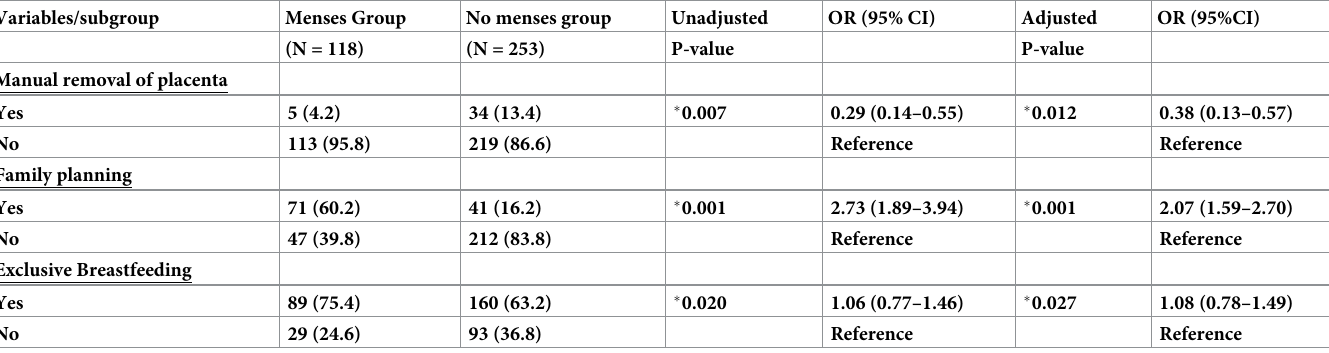
Conditional logistic regression was employed (P < 0.1) in the multiple regression analysis to control confounding variables: age, booking status, parity, mode of delivery, socio-economic class and gestational age at